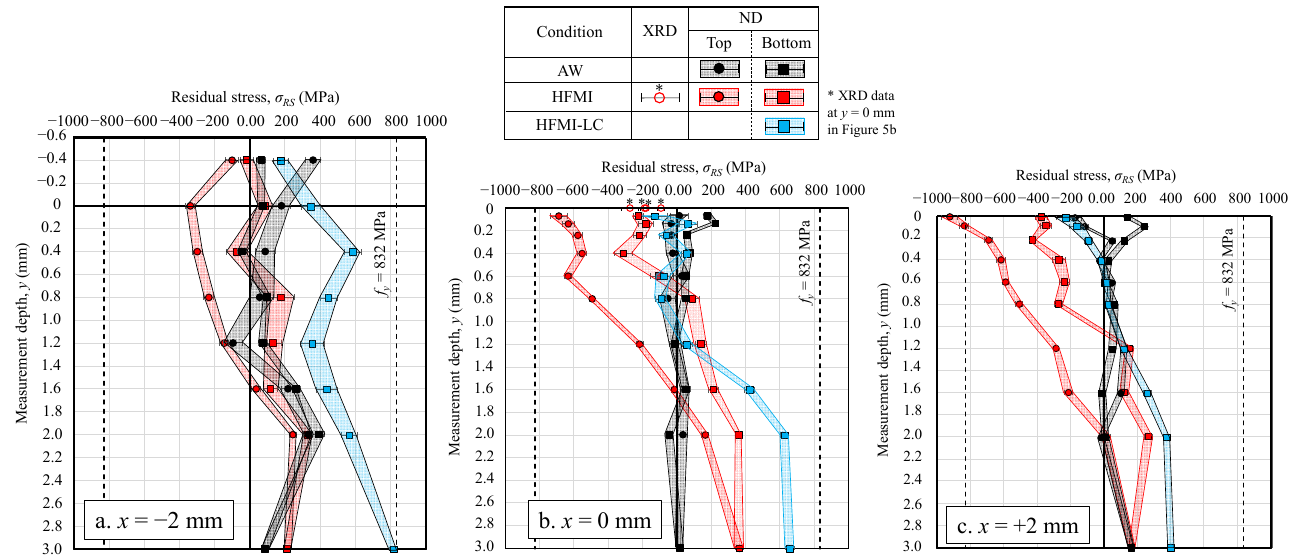
Figure 5. Residual stress profiles of AW, HFMI and HFMI-LC through thickness.